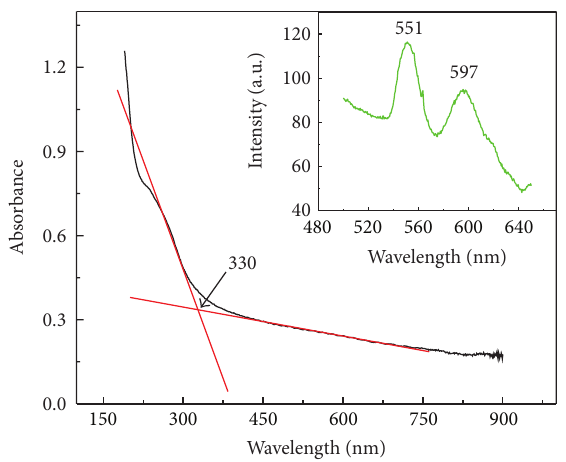
Figure 4: UV-vis absorption spectrum of KNbO 3 nanowires, the inset is the room temperature PL